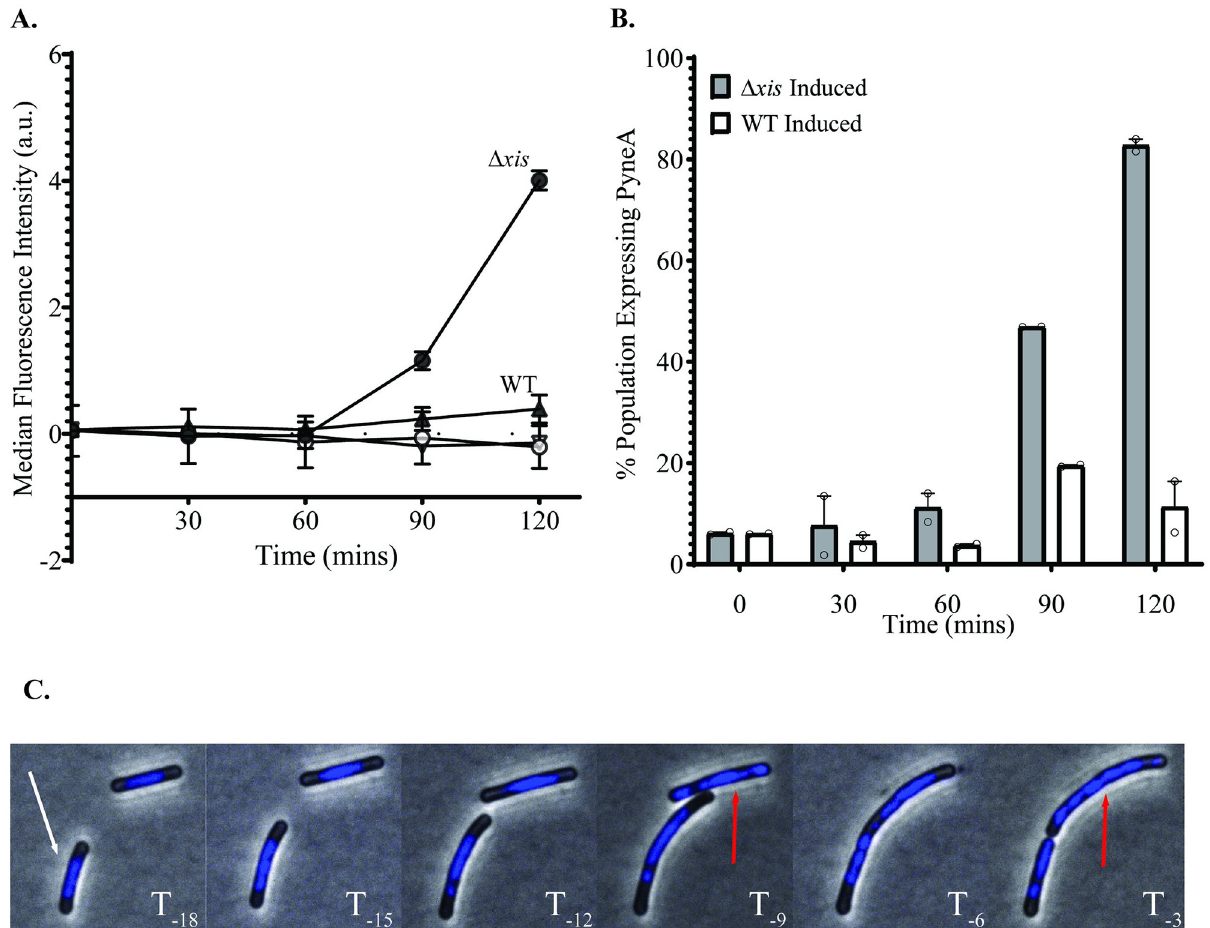
Fig 4. Activation of ICE Bs1 that is unable to excise causes DNA damage. A) Cells contained the SOS reporter P yneA - mNeongreen . Strains were grown at 37˚C in a defined minimal medium with L-arabinose as the carbon source. Expression of rapI (P xyl-rapI ) was induced by the addition of D- xylose. Samples were then spotted onto agarose pads and imaged at the indicated times. The average median fluorescent intensity of individual cells from at least 2 experiments is plotted as a function of time after addition of xylose. WT = SAM426; Δ xis = SAM427. WT Induced = filled triangles; WT Uninduced = upside down open triangle; Δ xis Induced = filled circles; Δ xis Uninduced (no xylose) = open circles. Error bars indicate standard error of the mean. B) Fraction of population gated as SOS+ based on ICE Bs1 uninduced distribution. Same experiment as A . Points represent mean from an individual experiment. Error bars indicate standard error of the mean. C) Induction of ICE Bs1 Δ xis (SAM427) causes chromosome abnormalities. Experimental conditions were the same as in panel 4 A . After 60 mins of ICEBs1 induction, cells were washed and spotted onto agarose pads that contained CH medium and DAPI. Images were captured every 3 mins. The indicated times (T ) indicate the number of minutes before lysis of the cell -x indicated by the white arrow in the bottom left of the first panel. Red arrows indicate cells with abnormal chromosomes right before lysis. Note: Both cells present at T lyse by T -18 0